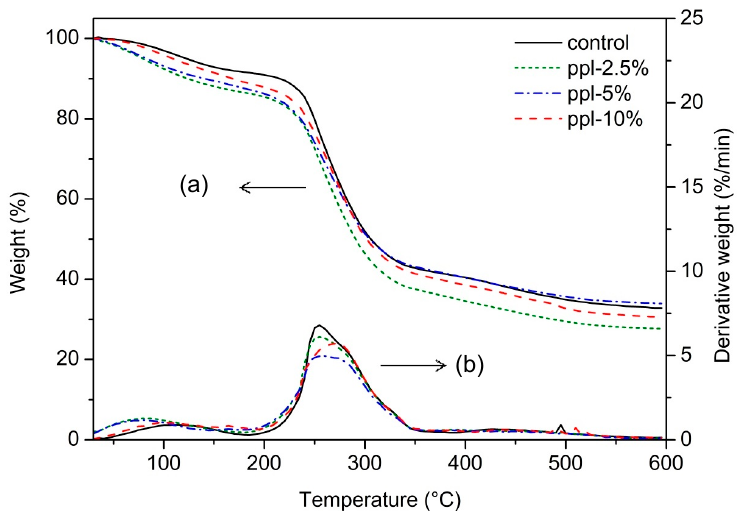
Figure 7. Thermal stabilities of RS, CMCh, and RS/CMCh blend films; ( a ) TGA thermogram and ( b ) DTG thermogram.